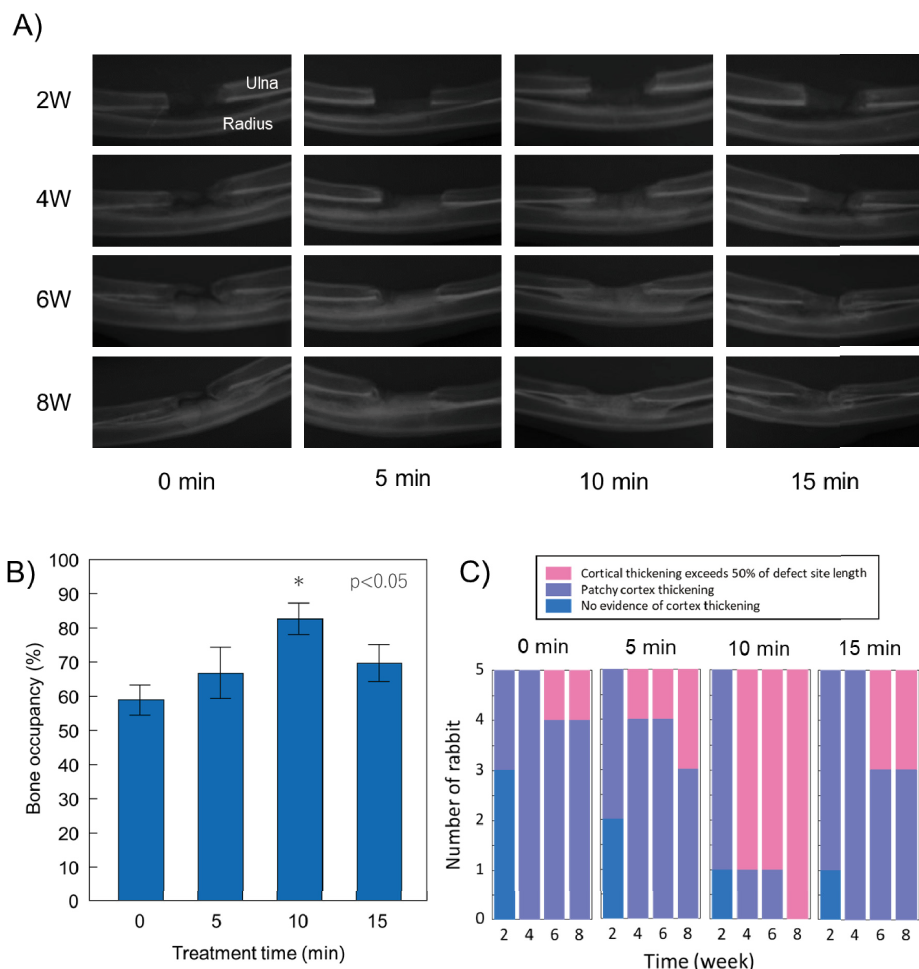
Fig 2. X-ray imaging results of a large bone defect model of rabbit were taken up to 8 weeks. 2A shows X-ray images as depended on the plasma treatment time. 2B shows bone occupancy of bone defect site at 8 weeks after a single plasma treatment and 2C shows evaluations of cortical thickening and patchy cortex thickening for treatment times at every two